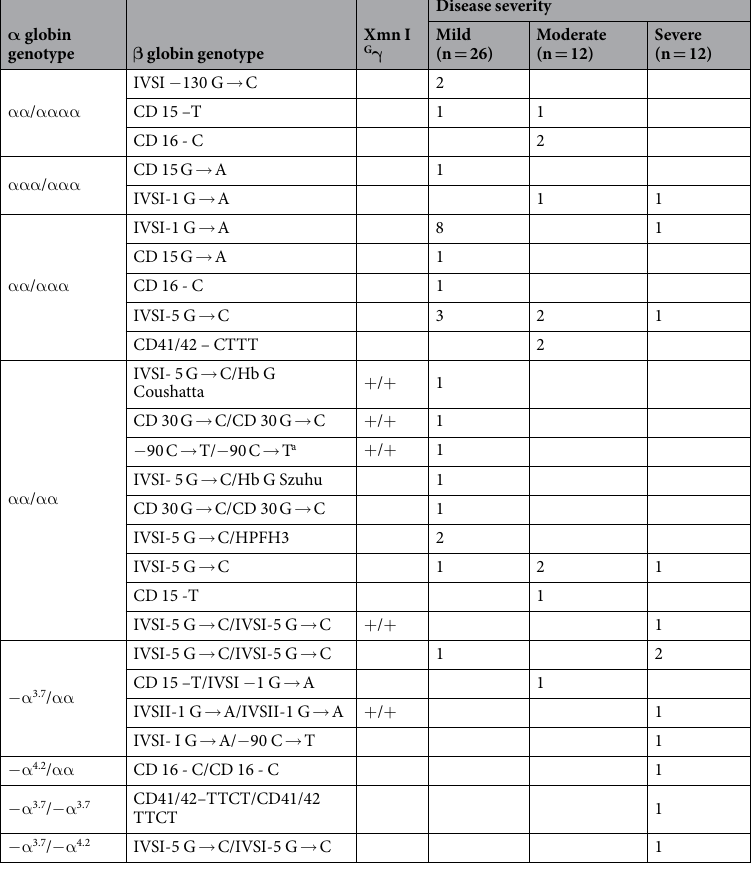
Table 4. Genotypes of 50 Sri Lankan β TI patients, and their association with disease severity. Notes a patient also had